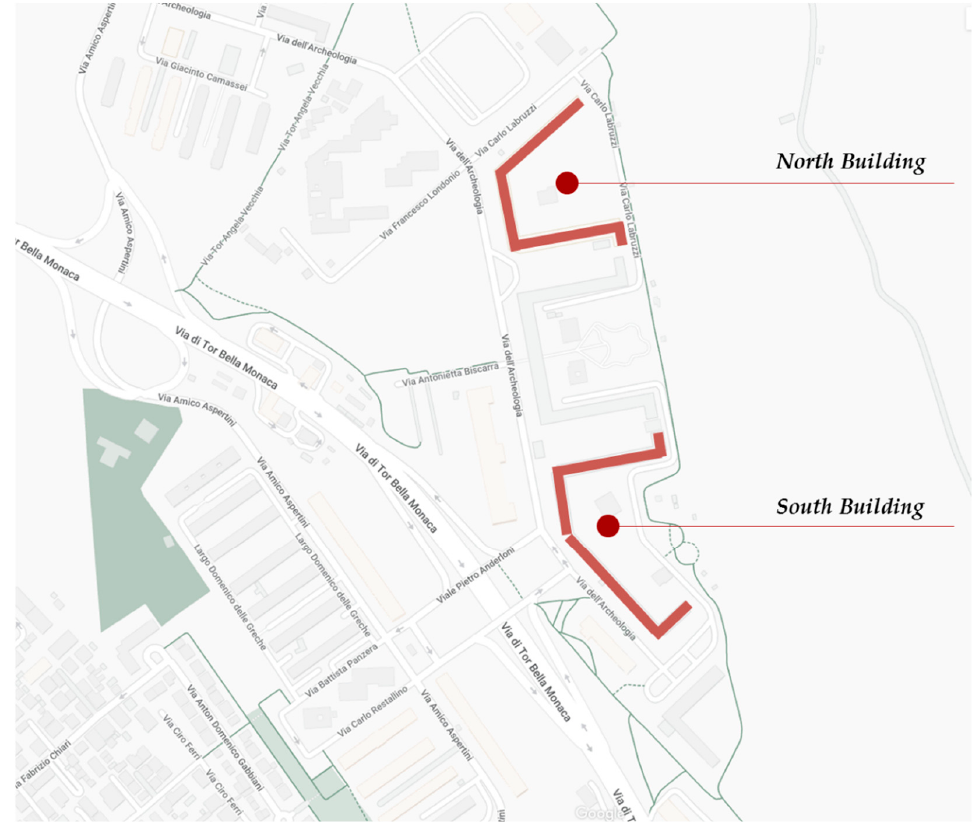
Figure 7. Tor Bella Monaca North and South Buildings.